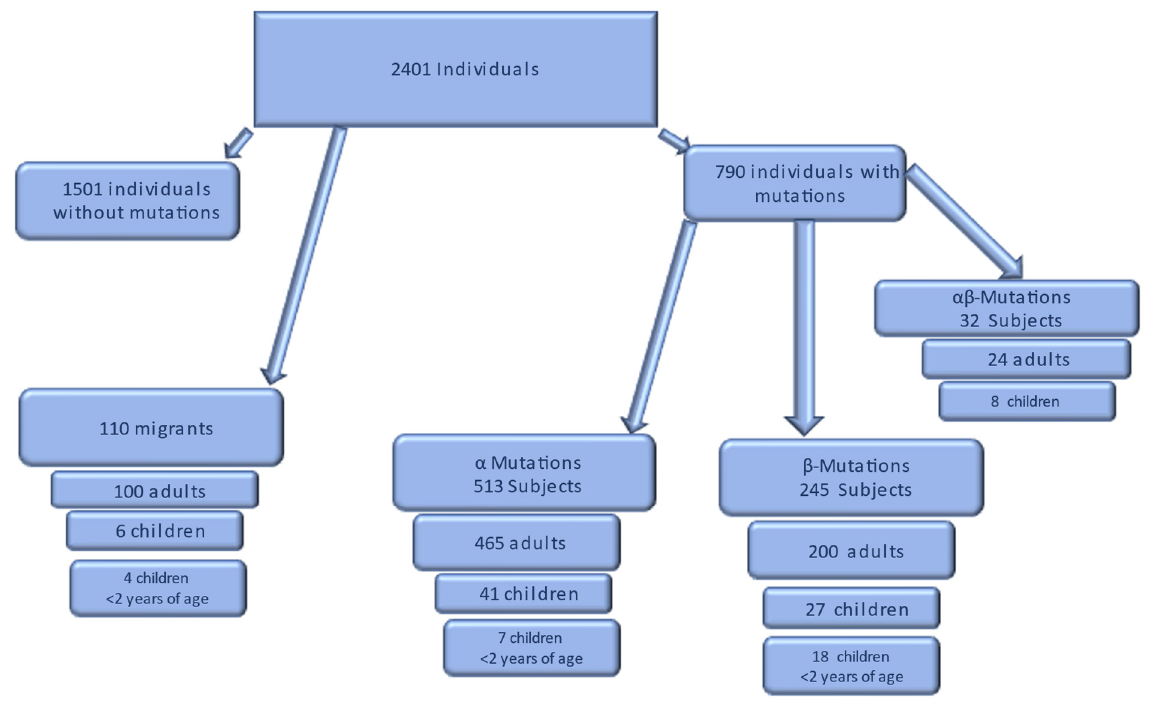
Figure 1. Schematic representation of study’s sample.